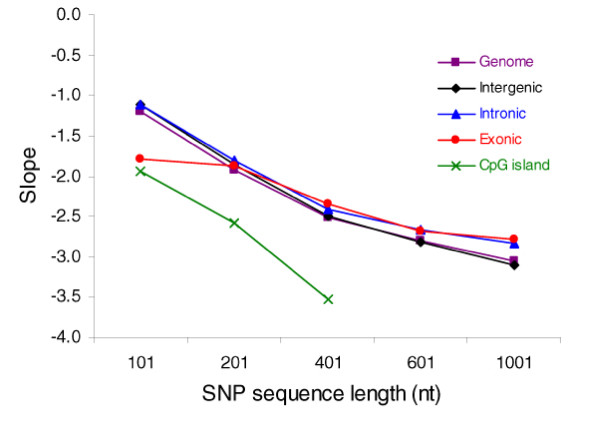
Slopes of linear regression lines. In CpG islands, the slopes for lengths 601 and 1001 nt were not included due to the insufficient number of SNPs in low GC-content bins.